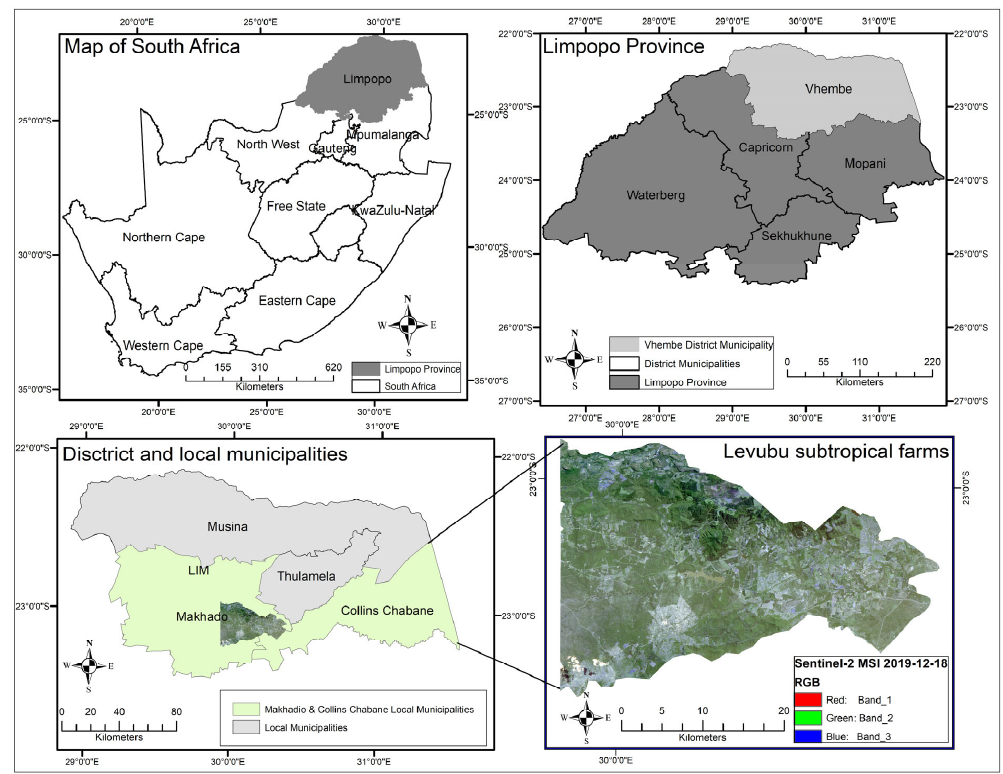
Figure 2. Map of the study region, depicting the Levubu subtropical farming region located in the Makhado and Collins Chabane Local Municipalities (lime green) of the Limpopo province (grey), South Africa.